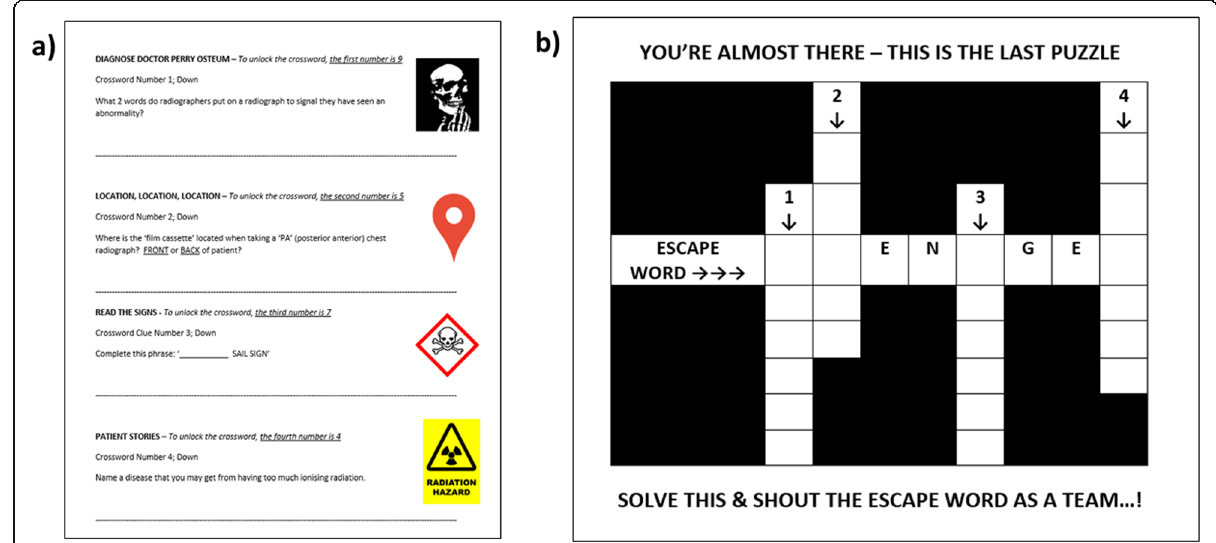
Fig. 6 Crossword puzzle. a This image demonstrates the four different notes that were contained within the four containers shown in Fig. 5. They provide clues to the crossword puzzle ( b ). The answers to the crossword are 1 — RED DOT; 2 — FRONT; 3 — THYMIC; 4 — CANCER. The escape room word was ‘ ROENTGEN ’